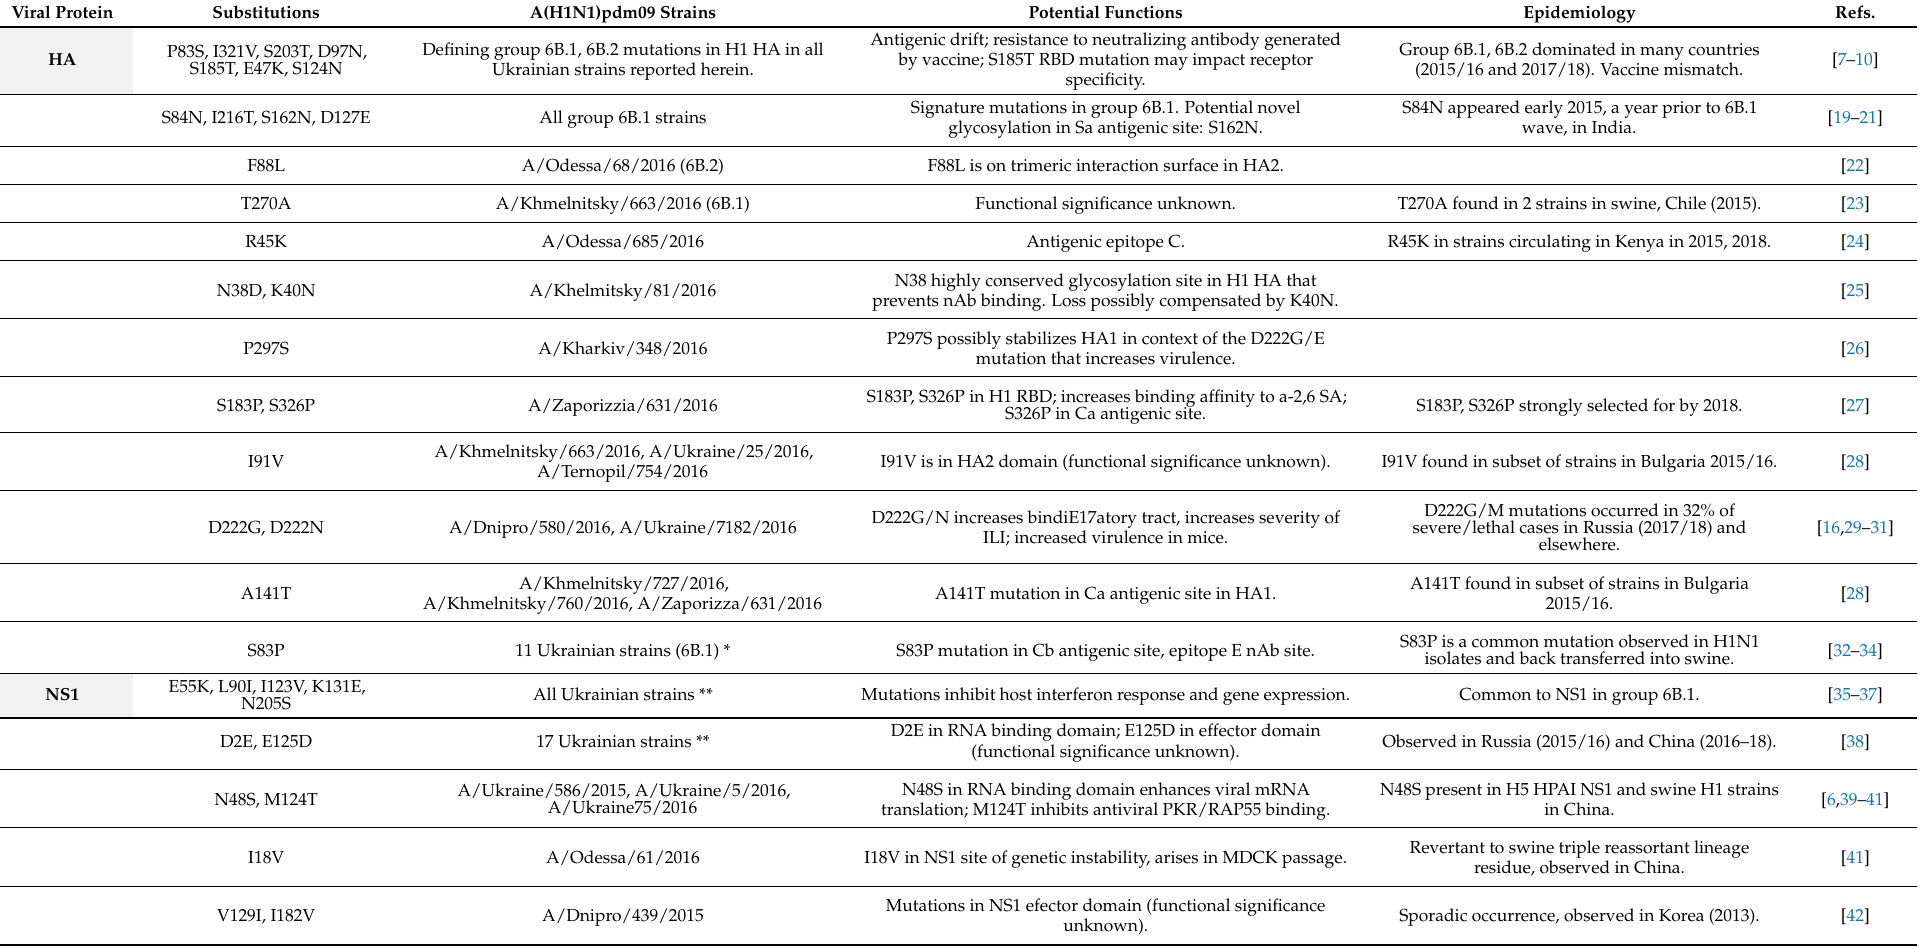
Table 1. Selected key functional amino-acid substitutions in A(H1N1)pdm09 strains, 2015/16,